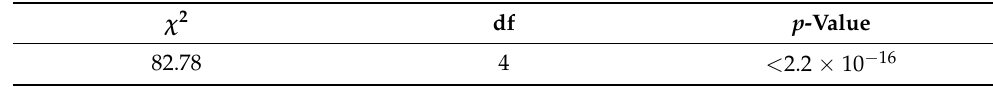
Table 3. The results of Hausman